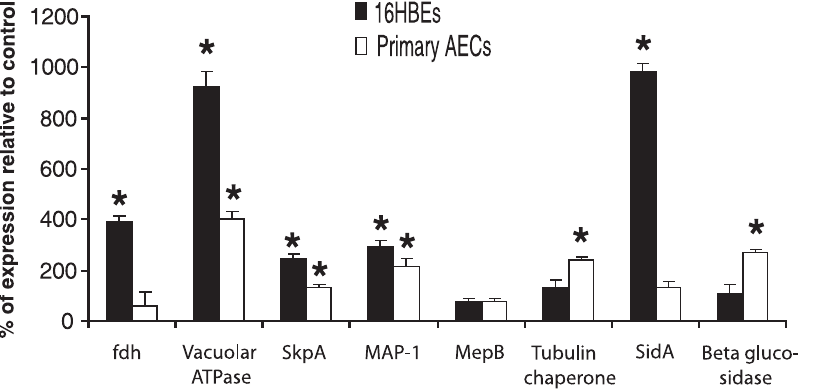
Figure 3. Relative mRNA expression levels of A.fumigatus genes as determined by RT-qPCR. RNA was obtained from four co-incubations each of A. fumigatus conidia with 16HBE14o- (grey bars) or primary human bronchial epithelial cells (AECs) (white bars). Height of each bar represents expression of gene in co-incubated condition relative to conida alone control (mean 6 SE). (* p , 0.05).